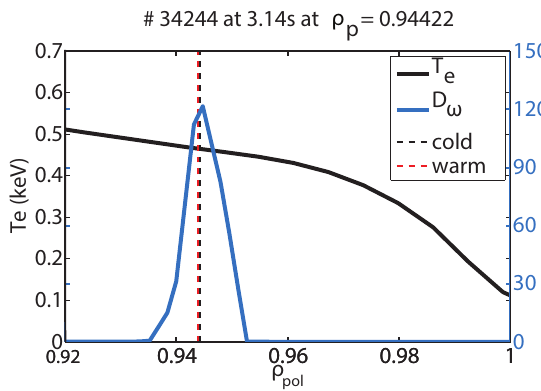
Figure 2. #34244 at t = 3.14s: Midplane edge channel of f = 110.27GHz of the ECE diagnostic. The cold resonance posi- tion, determined by the magnetic field strength, is shown as black dashed line. A birthplace distribution of the observed intensity ( D ω ) is shown in blue. The peak of the D ω represents a warm resonance for a respective channel. The T e profile is shown in a solid black